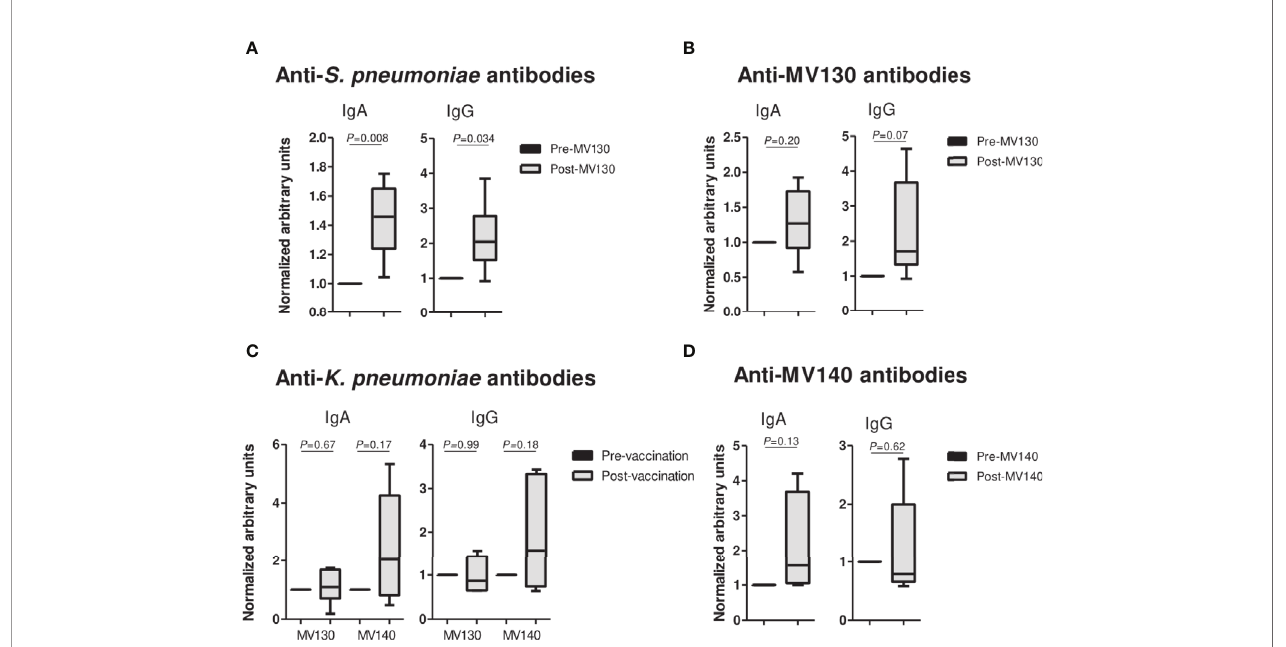
FIGURE 4 | Prophylaxis with mucosal bacterial vaccines increases serum antibody production. (A – D) Serum IgA (left panels) and IgG (right panels) antibodies against the speci fi ed pathogens (A, C) or the bacterial mixture (B, D) , collected from subjects before vaccination and at 18-45 months after initiating either MV130 or MV140 immunotherapy. Data in each individual subject are normalized to the corresponding pre-vaccination value. Results from N=6 (MV130) or N=5 (MV140) individuals are shown as mean+SEM for each immunoglobulin. P values were calculated using one sample t -test with 1 as theoretical mean